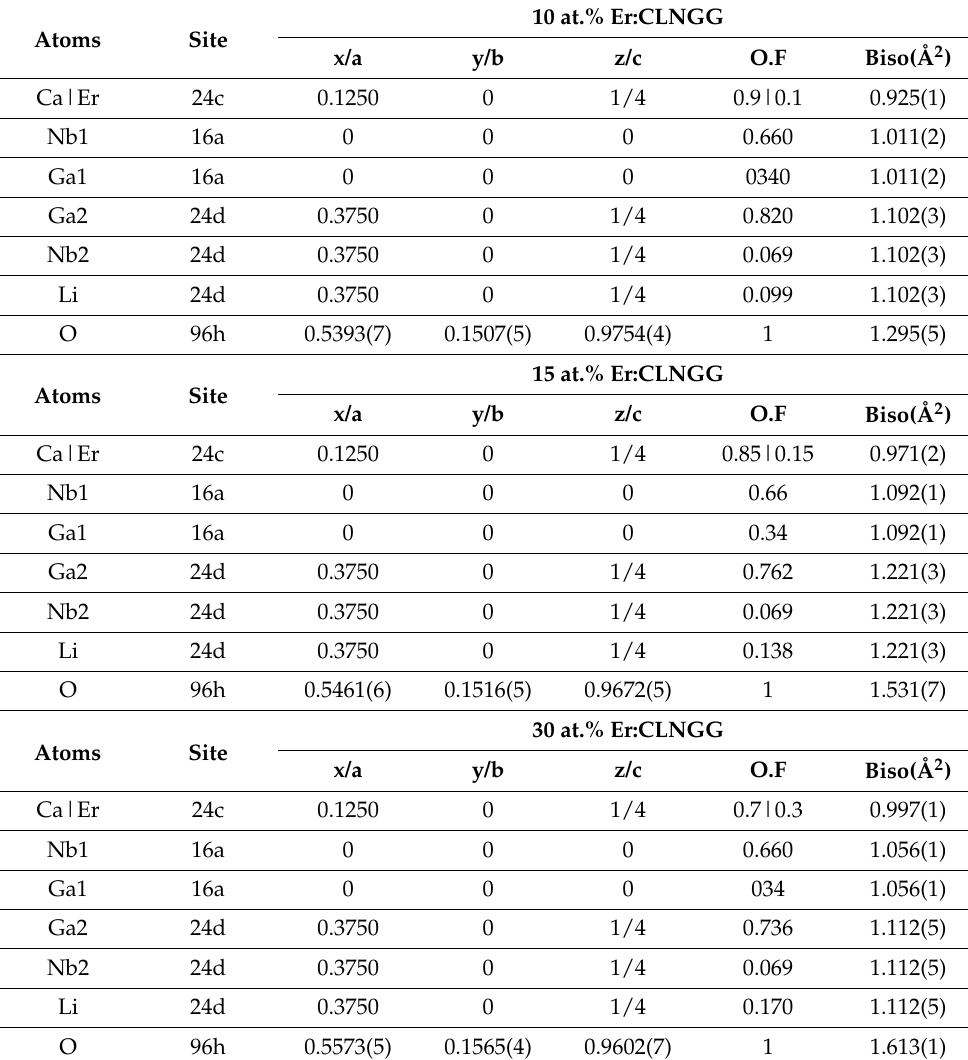
Table 2. Atomic coordinates, sites, occupancy factors (O.F) and isotropic displacement parameters Biso (Å 2 ) for 10, 15, and 30 at.% Er:CLNGG